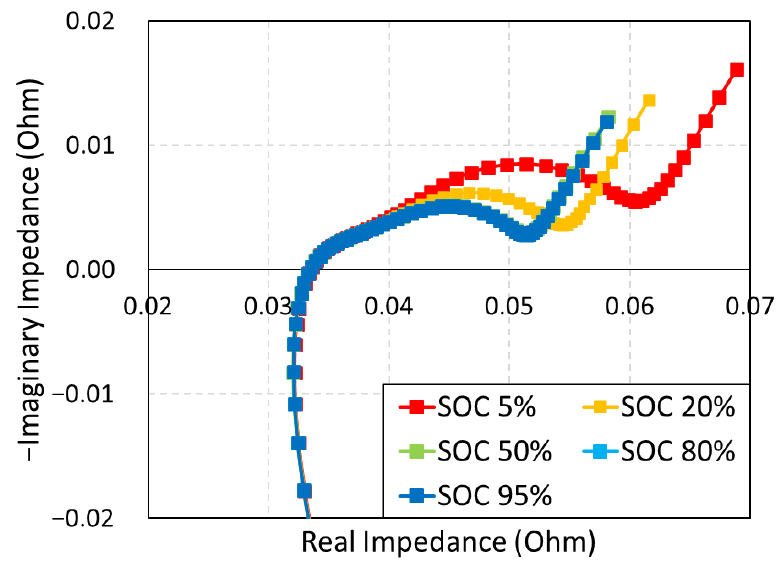
Figure 10. EIS measurements in an aged cell (80% SOH) at 5, 10, 15, 20 and 25% SOC.